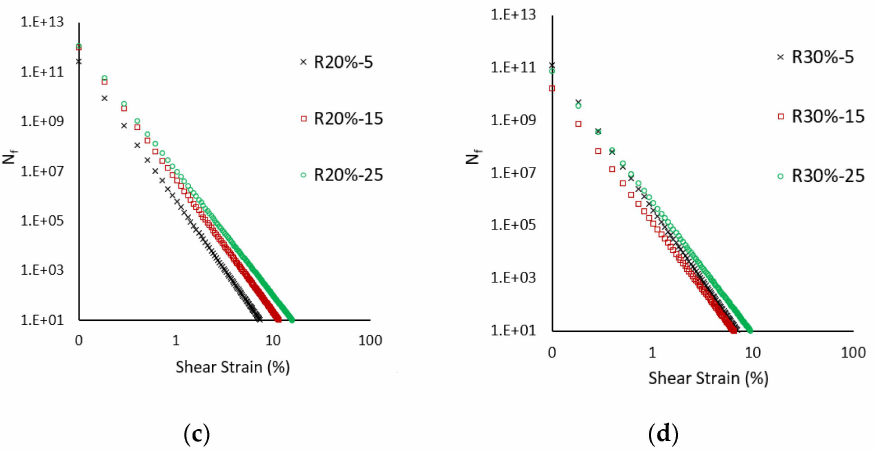
Figure 7. Fatigue life as a function of shear strain at different temperatures for ( a ) neat binder ( b ) 10%, ( c ) 20%, and ( d ) 30% filler content.